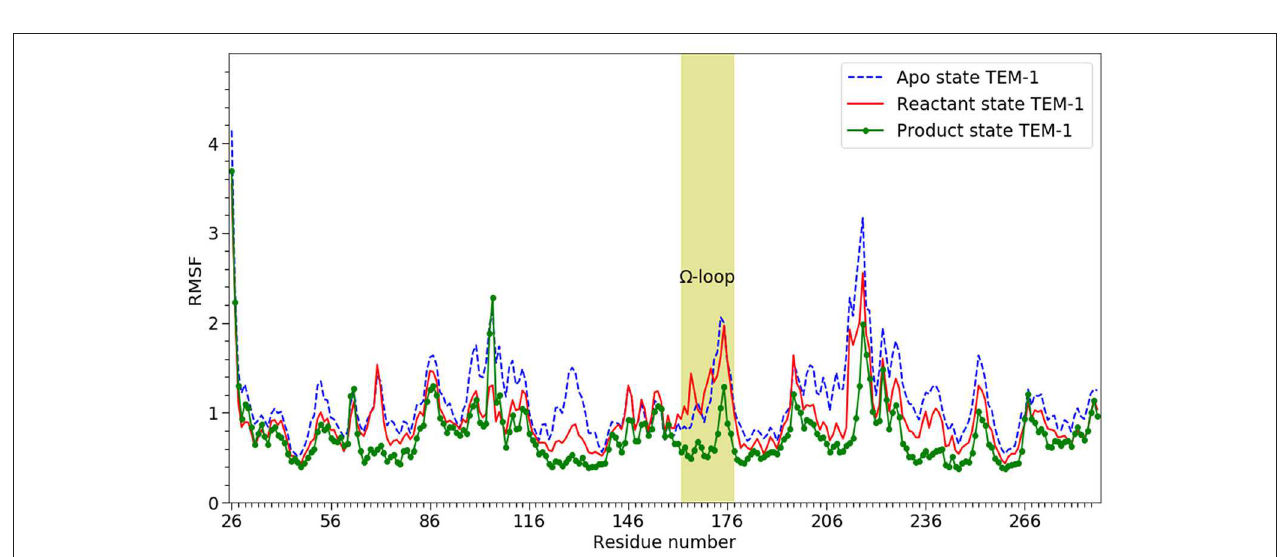
FIGURE 3 | The RMSF of α -carbons (C α ) from 26 to 288 on TEM-1 β -lactamase in apo (blue dash line), reactant (red line) and product states (dot line), (cid:127) loop (residue 163–180) highlighted. All three states have overall similar distribution but with significant difference. The product shows the lowest overall RMSF. The apo state show the highest overall